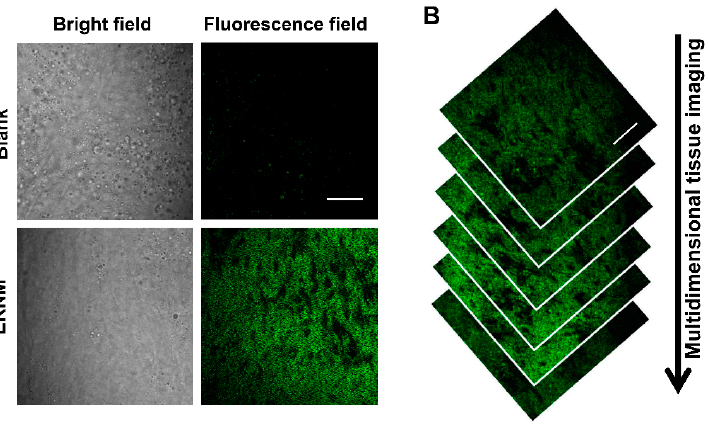
Figure 4. ( A ) Two-photon fluorescence images of the CYP1A in rat liver slices with ERNM . ( B ) Multidimensional two-photon fluorescence images of liver tissue treated with ERNM . Scale bar: 100 μ m.